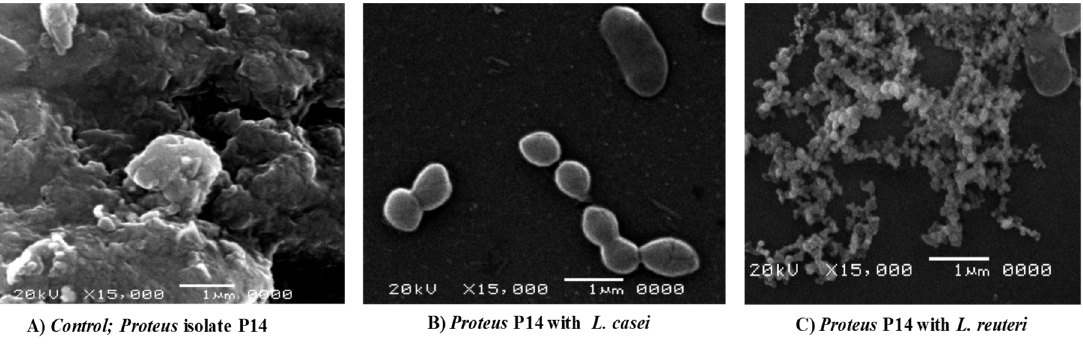
Figure 4. Scanning Electron micrographs (SEM) (magnification: × 15,000). ( A ) Biofilm formation of the P14 isolate in the absence of Lactobacillus spp. (control). ( B ) Biofilm formation of the P14 isolate in the presence of L. casei . ( C ) Biofilm formation of the P14 isolate in the presence of L. reuteri